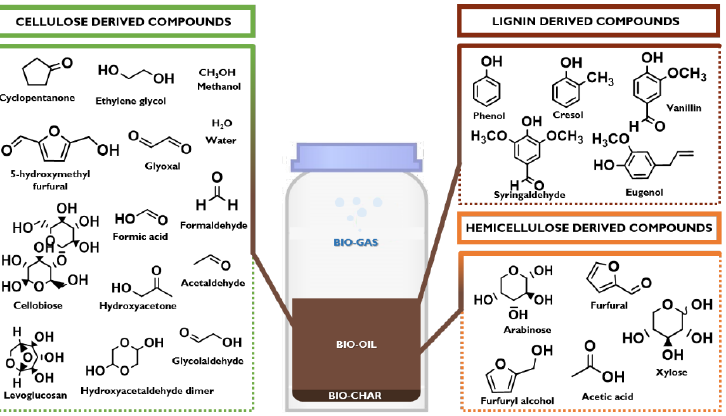
Figure 1. A simplified chemical composition of bio-oil: main lignocellulose-derived